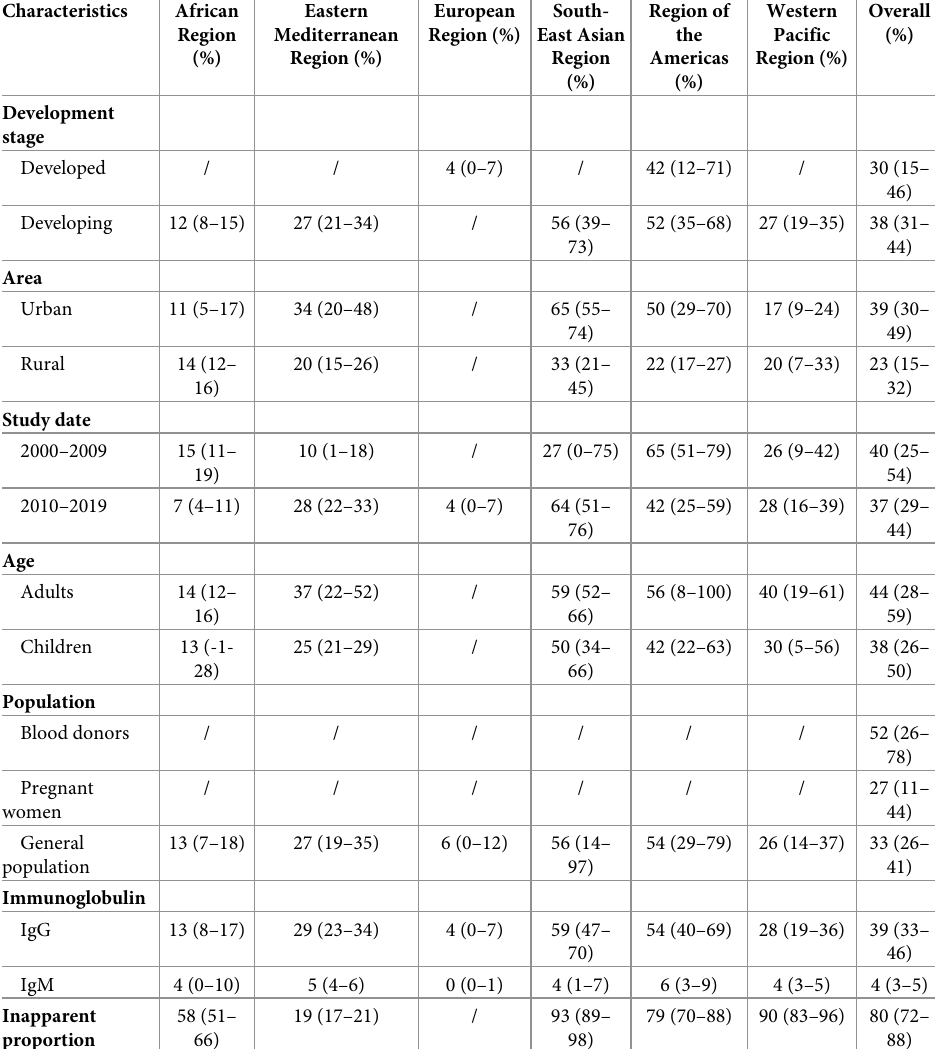
Table 2. Seroprevalence of DENV infection and subgroup